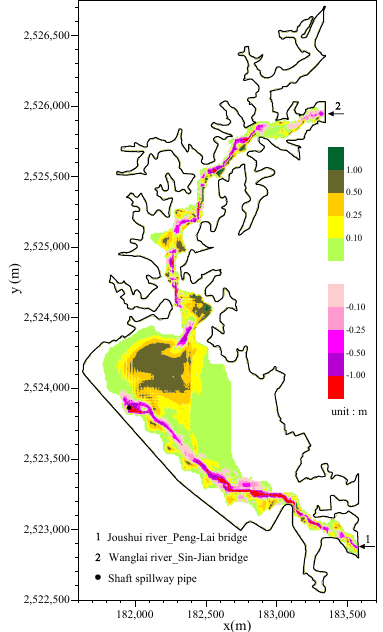
Figure 7. Bed evolution in the reservoir during a two-year return period, t = 120 h.